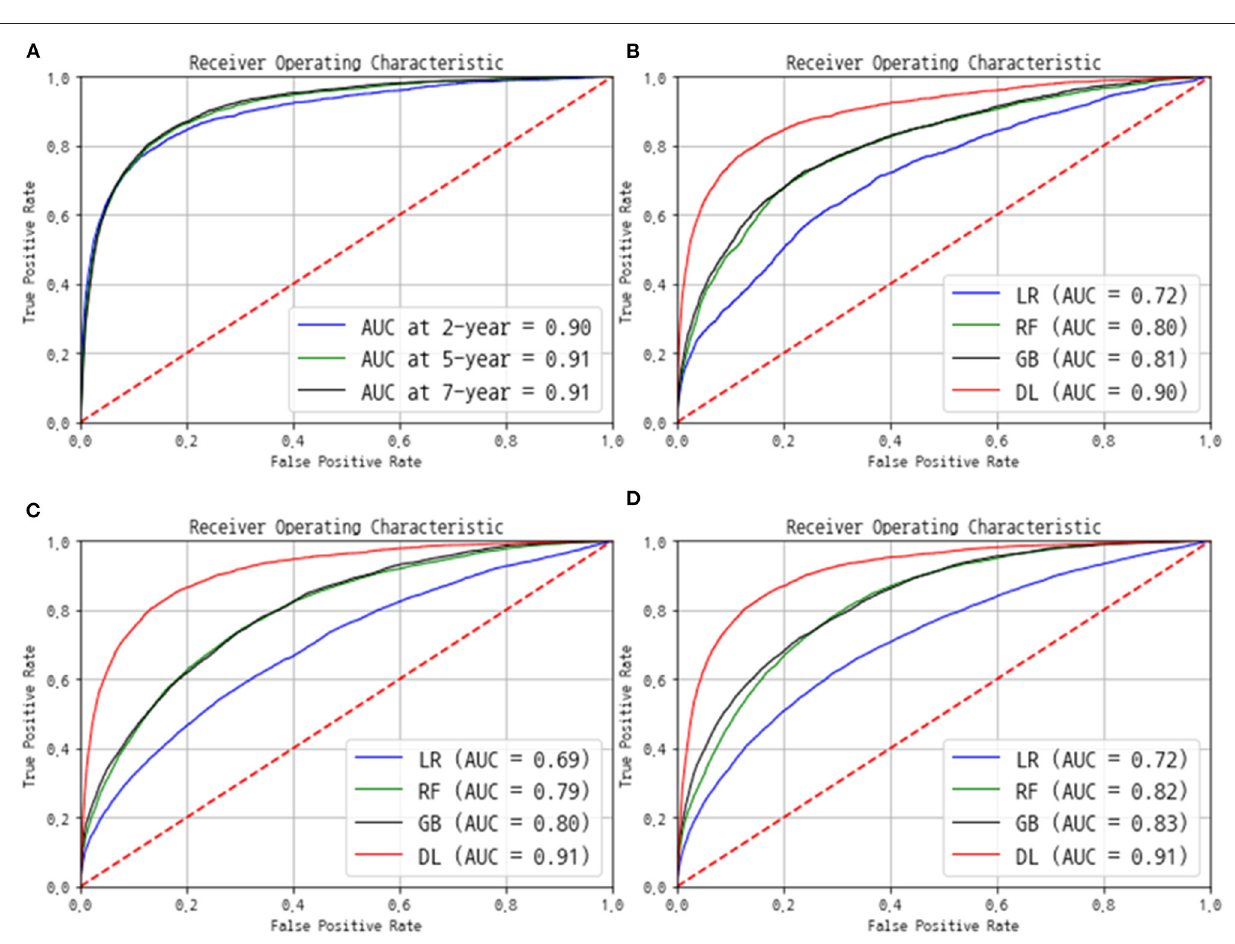
Frontiers in Oncology |